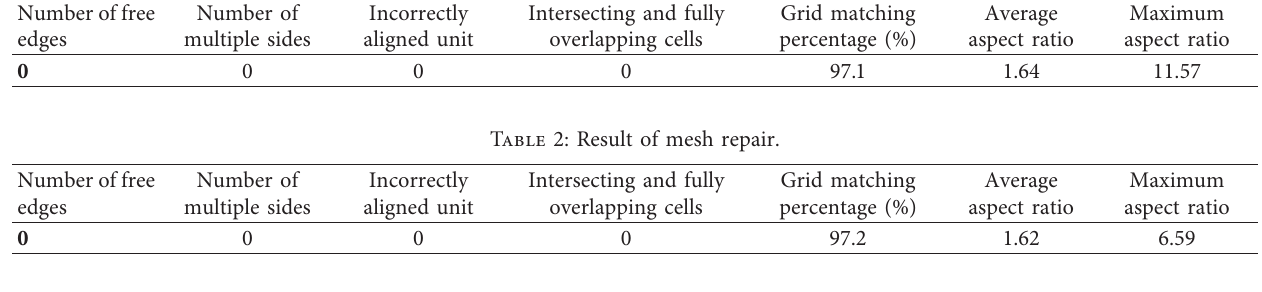
Table 3: Basic properties of two modified PP.